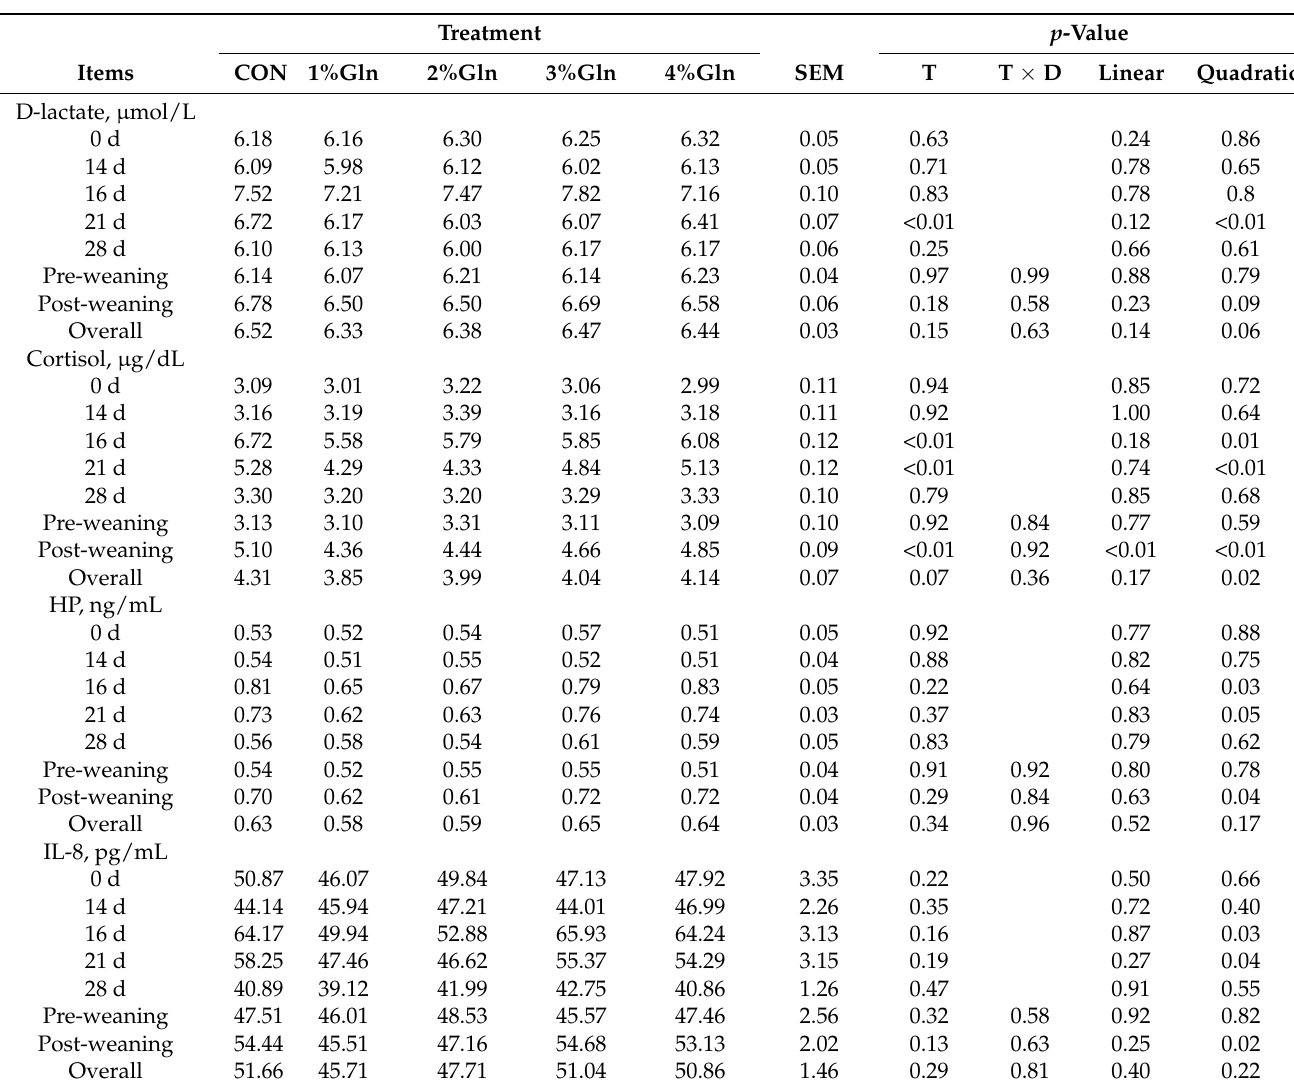
Table 3. Serum stress indicators of calves among different groups (N = 9 per group). Treatment p